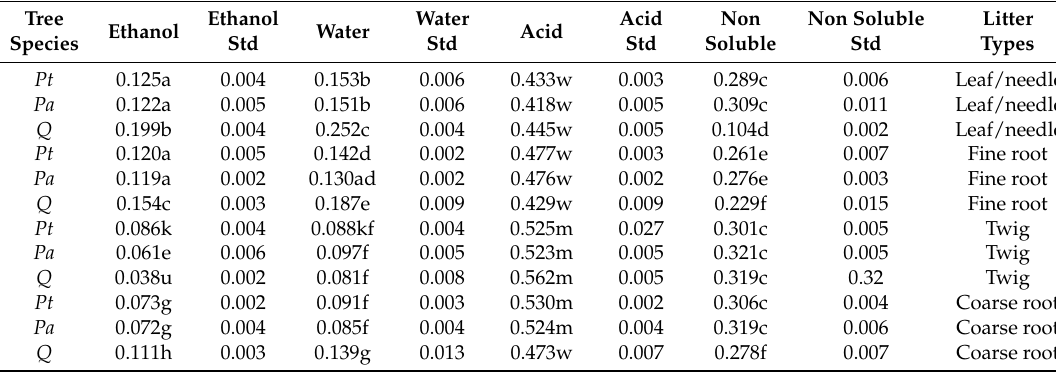
Table 6. Chemical compound groups of litter among tree species.